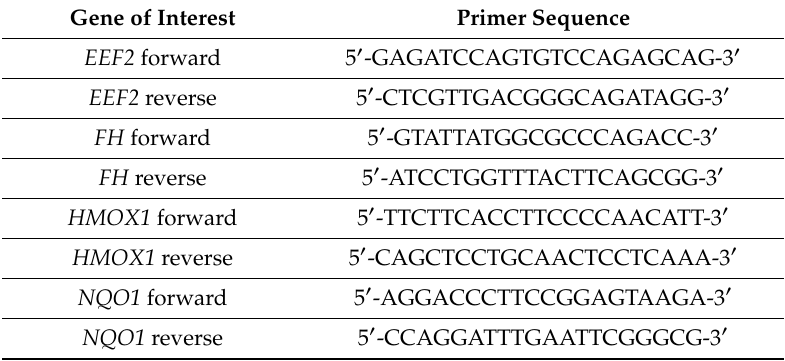
Table 1. Sequences of primers used in